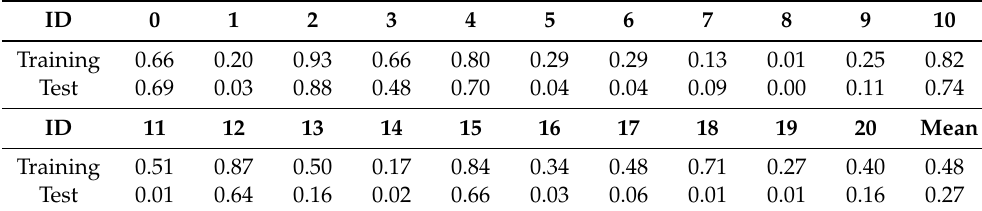
Table 4. IoU scores for the respective Cityscapes